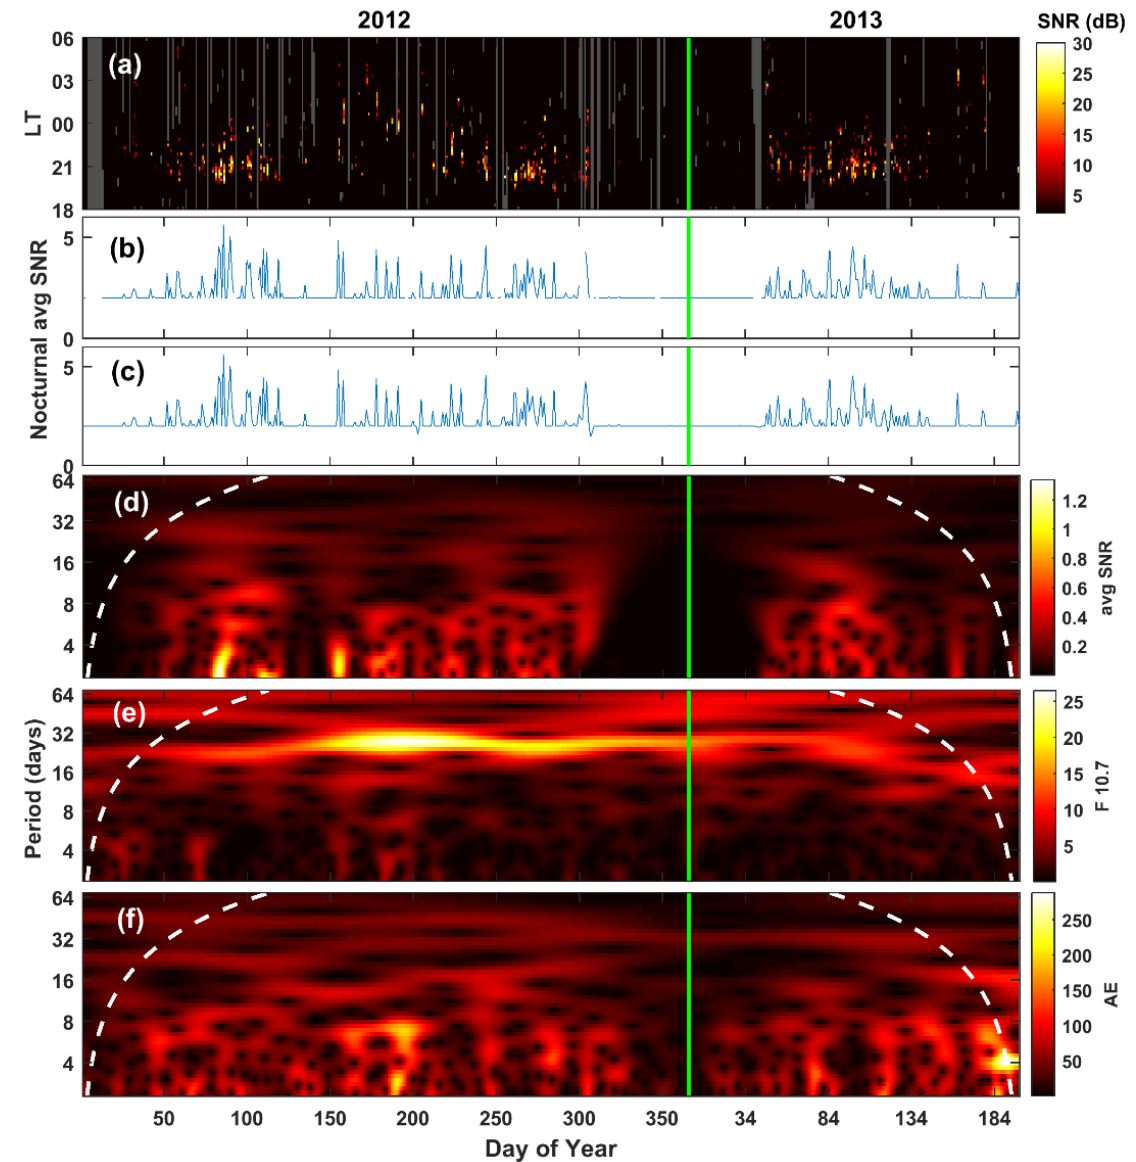
Figure 2. ( a ) Local-time day-of-year map of radar SNR from a height of 300 km in 2012–2013 (rill mid-July). ( b ) Day-of-Year variation in nocturnal average SNR for the same period. ( c ) Same as ( b ), but with data gaps filled with spline interpolation. ( d ) Wavelet scalogram of SNR derived from day series in panel ( c ). ( e , f ) Wavelet scalogram of F10.7 and the AE index, respectively. White dashed lines indicate the cone of influence.